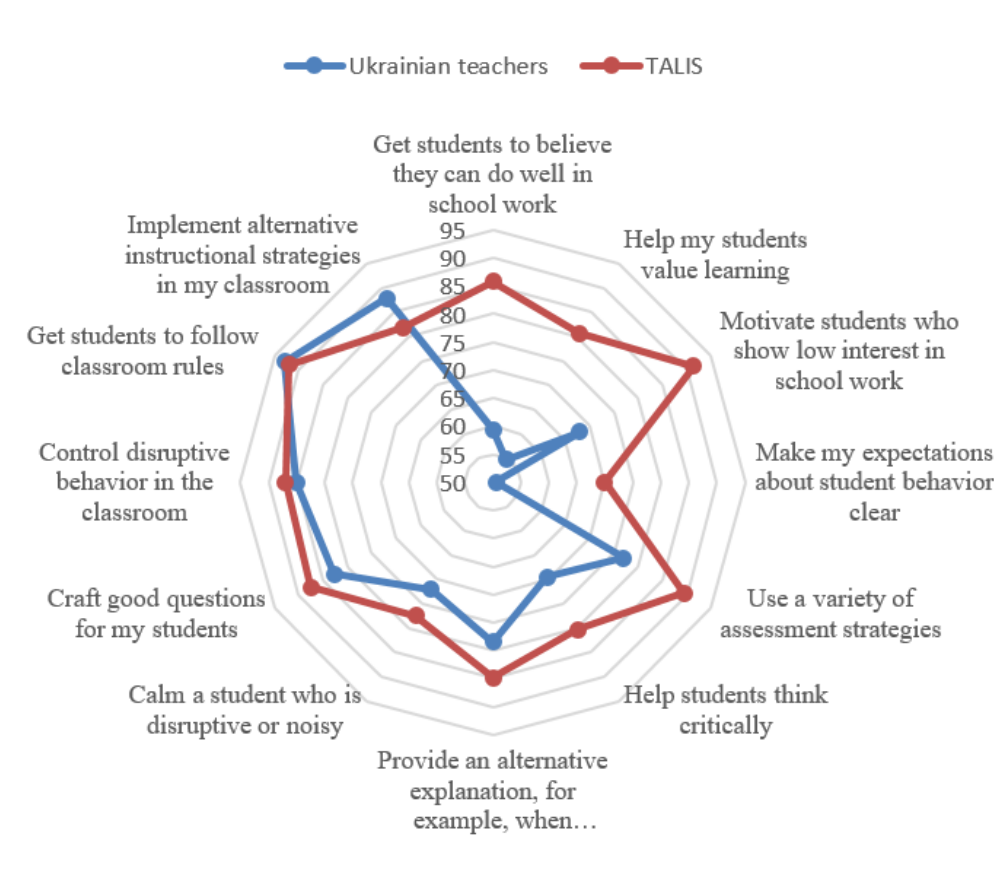
Figure 78: Presentation of paper